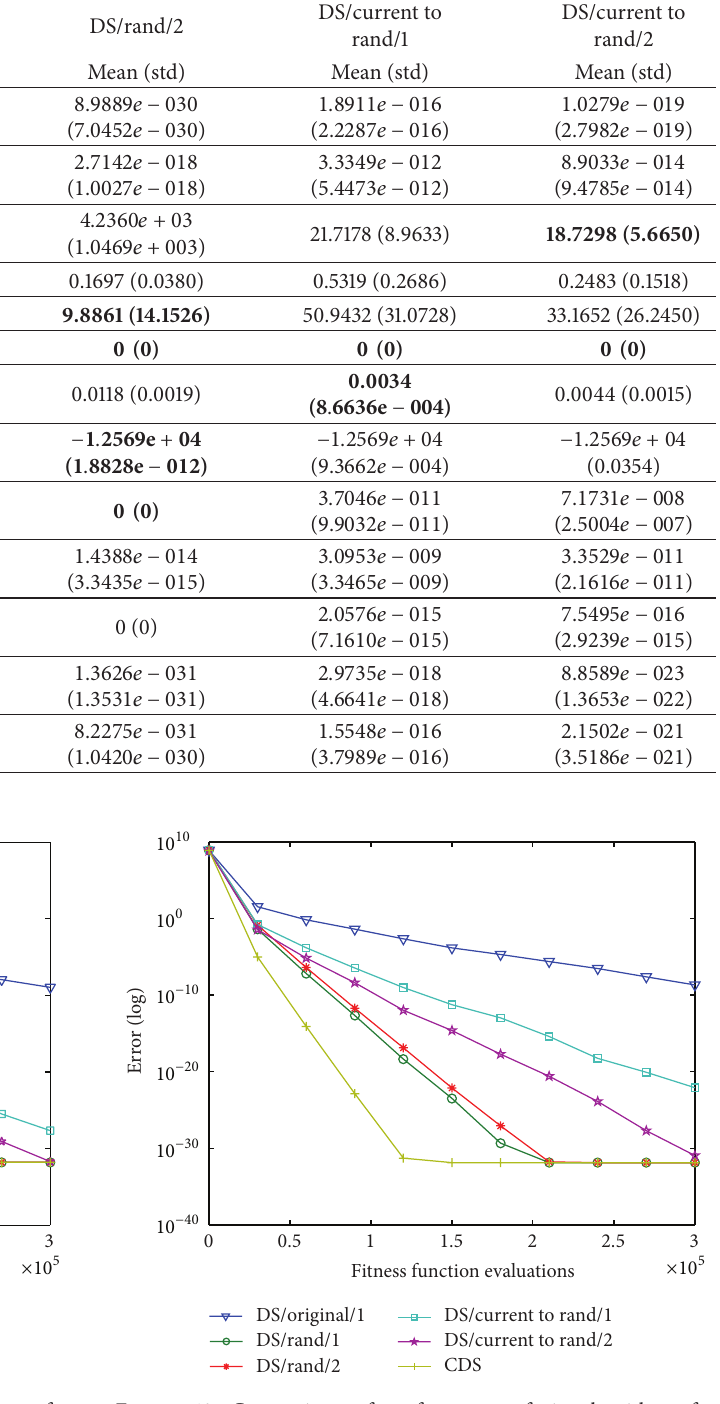
Figure 11: Comparison of performance of six algorithms for minimization of 𝑓 12 with dimension 30.